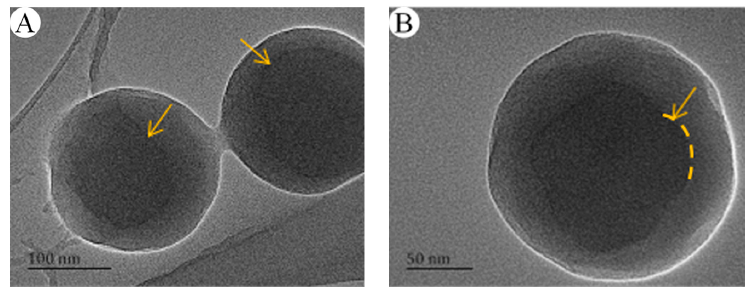
Figure 11. TEM images of the PSA0 nanospheres with different scale bars ( A ) 100 nm, ( B ) 50 nm.